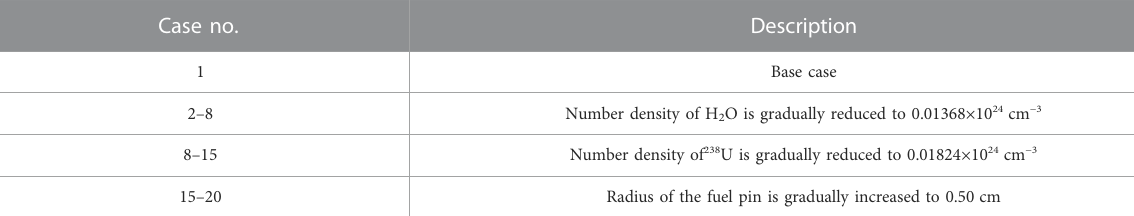
TABLE 4 Design of the single-cell cases. Case no.